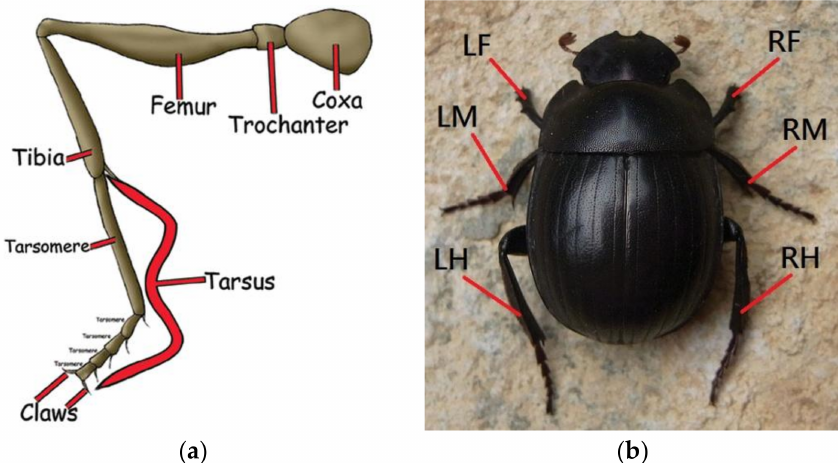
Figure 2. The body structure of a dung beetle: ( a ) the major leg segments of adult insects [16]; and ( b ) the abbreviations of dung beetle’s legs [17].